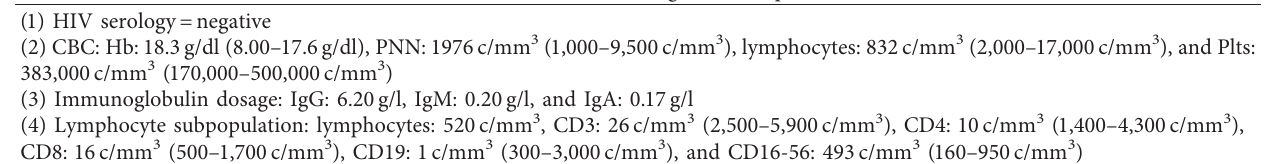
Figure 1: Pedigrees of families with RAG2 mutation: case 1 and case 2. Squares: male subjects; circles: female subjects; black filled symbols: patients with mutation; grey filled symbols: mutation carriers; crossed-out symbols: deceased Table 1: Immunological workup.